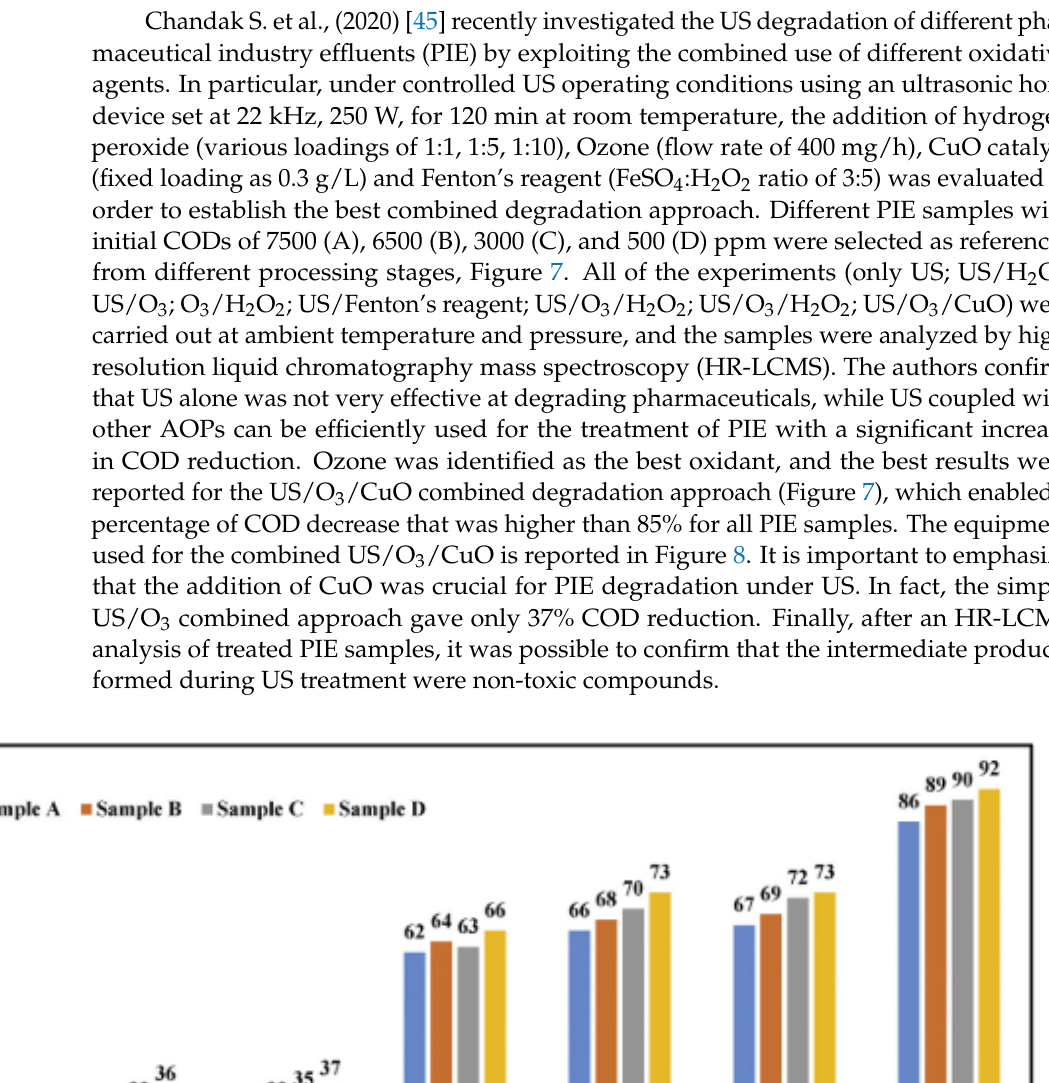
Figure 8. Schematic representation of experimental setup for degradation with US/ozone combina- tion. Reprinted with permission from [45]. 3. Photocatalytic Strategies Coupled with Cavitational Treatments Several studies on the photocatalytic degradation of antibiotics and their possible degradation pathway have been documented in the literature [62,63]. For example, Hu et al. (2016) [64] recently designed a composite material made of graphene, TiO 2 , and zeolite (ZSM-5) (identified as GTZ) that is suitable for the photocatalytic degradation of oxytet-